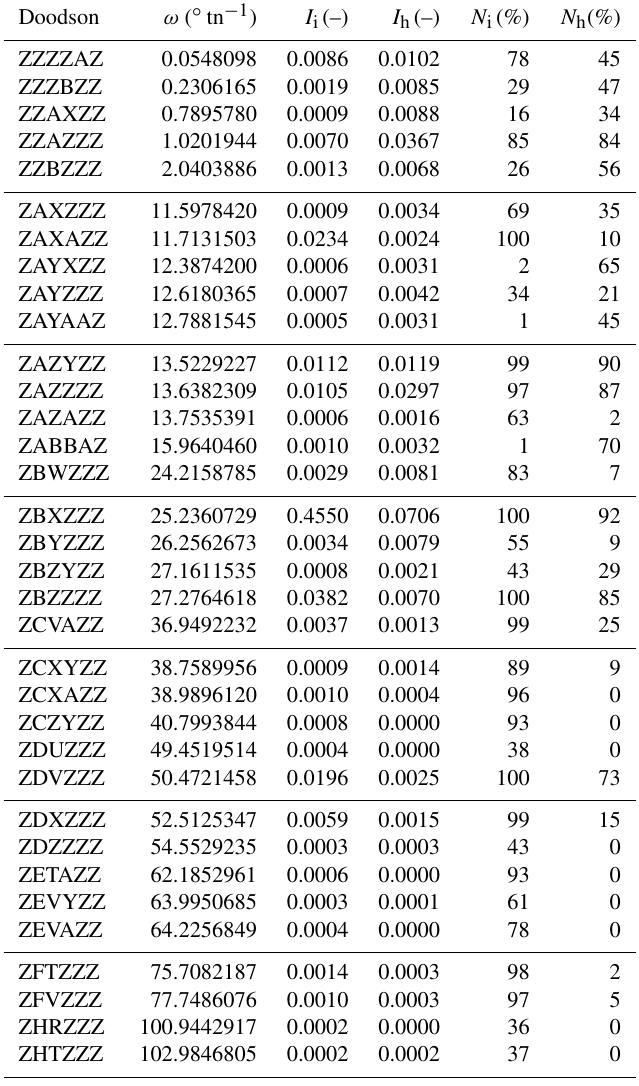
Table 3. The most important partial tides that were identified in the periodograms, based on the combined evaluation of data from all tide gauges. See Sect. 4.3 for information on selection criteria and I i , I h , N i and N h